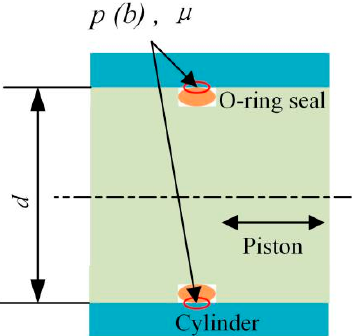
Figure 4. Schematic diagram of relevant parameters in friction calculation.